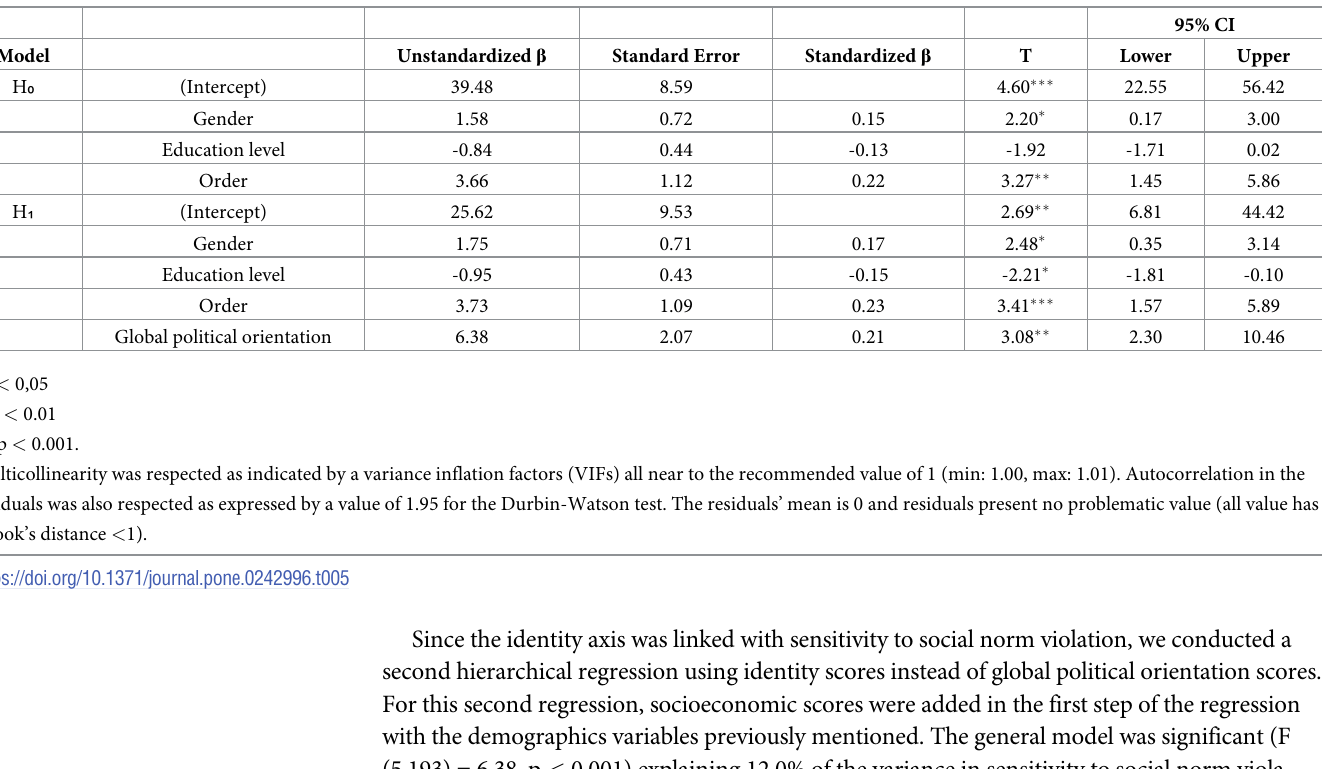
explained 1.8% of the variance. Hierarchical regression results are presented in Table 6. Table 6. Coefficients of hierarchical regression analysis for variables predicting sensitivity to social norm violation with identity and socioeconomic axes (n = 199).